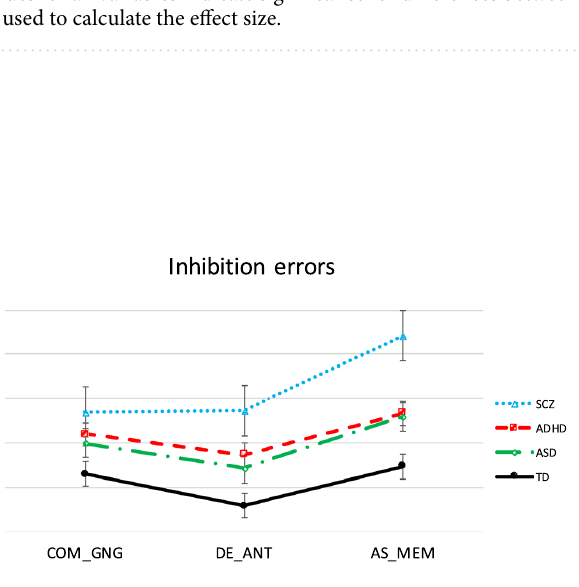
Figure 1. The graph represents the percentage of inhibition errors across tasks on which clinical groups most deviated from healthy controls, namely commission errors from the GNG task (“COM_GNG”), anticipatory saccades from the MEM task (“AS_MEM”) and regular direction errors from the ANT task (“DE_ANT”). The error bars represent one standard error of the mean. The effect sizes from the between-group subject ANOVA are also reported here. COM_GNG: η p2 = 0.098, DE_ANT: η p2 = 0.139, AS_MEM: η p2 =